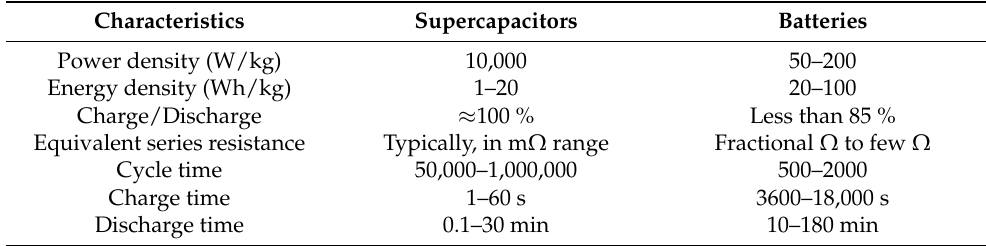
Table 1. Comparison of characteristics of supercapacitors versus batteries which supports the selection of supercapacitors in SCALoM-based converter applications.